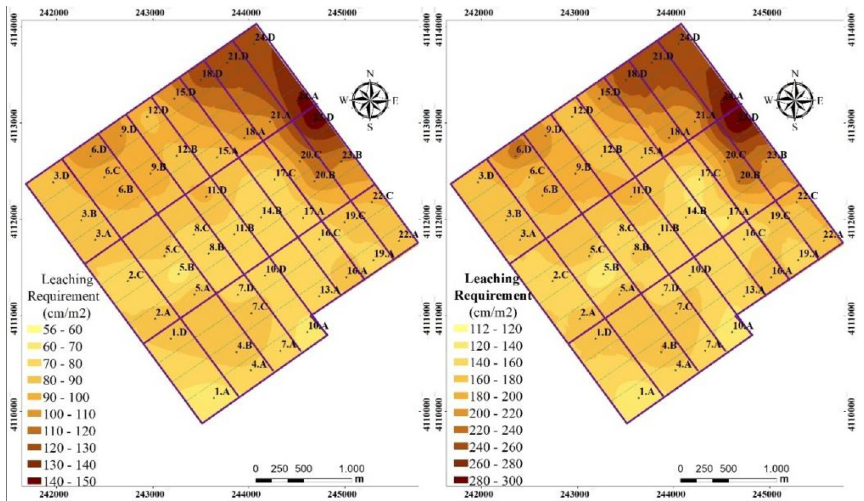
Fig 6. Spatial distribution maps for the amount of leaching water calculated for 60 and 120 cm depth of soils profile.